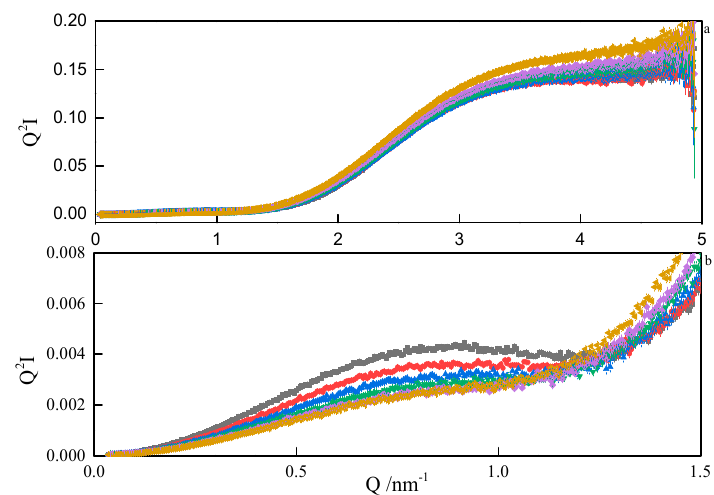
Figure 12. Kratky plots ( a ) and zoom ( b ) from SAXS analyses of 8-6-8 surfactant system at C s = 0.22 mol